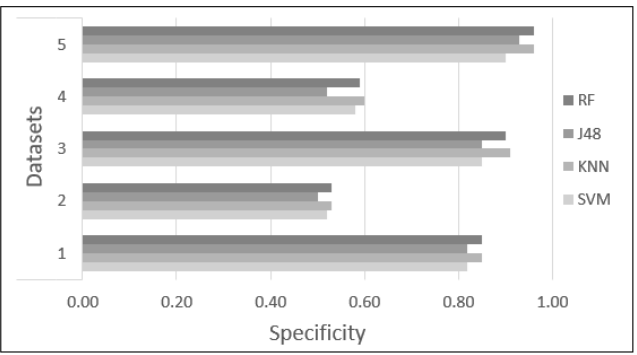
Figure 8. Difference in specificity among the different classification methods.